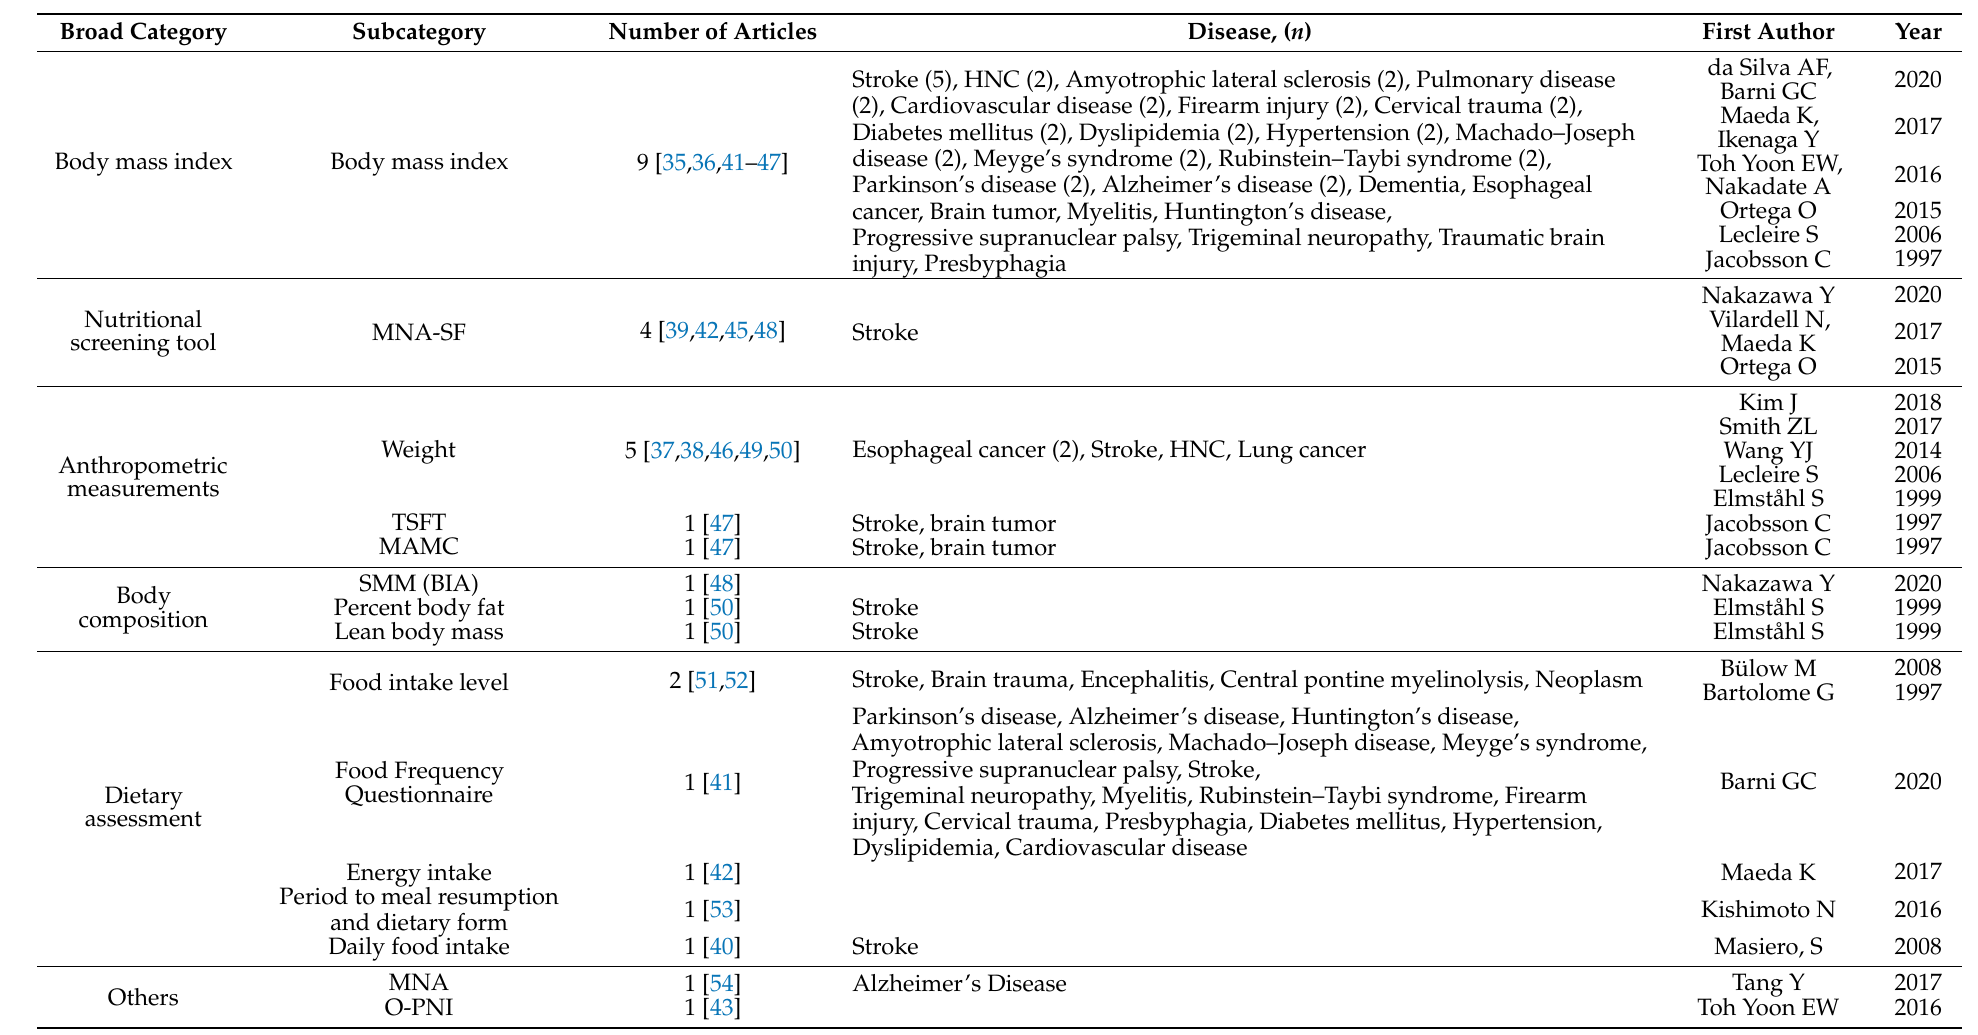
Table 1. Nutritional assessment items used for adult patients with